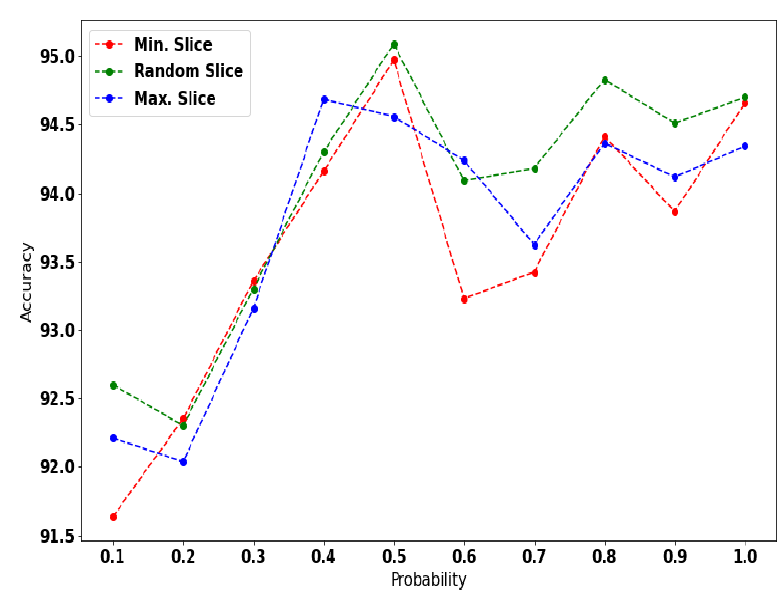
Figure 3. Hyperparameters: probability and slice size effect on